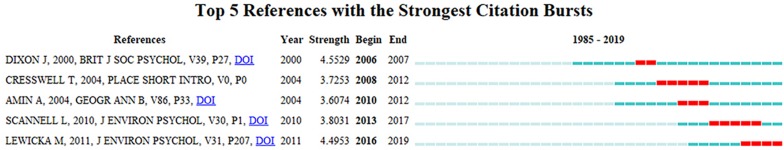
Top five references with the strongest citation bursts during 1985–2019. The red line segment indicates the beginning year and the ending year of the duration of the burst.